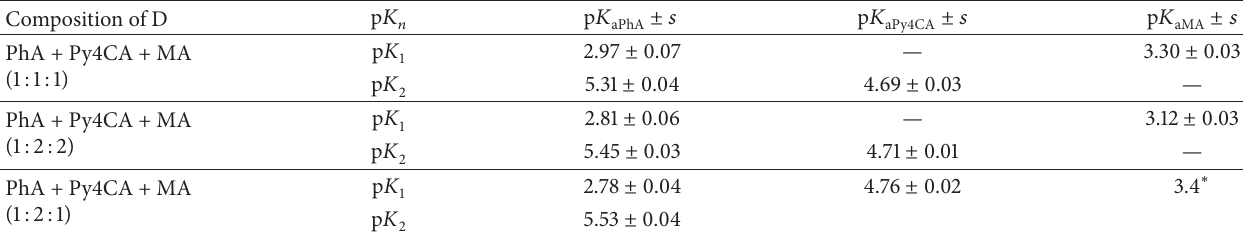
Table 3: The experimental p 𝐾 data obtained for the mixture of PhA, Py4CA, and MA at various compositions of titrand D. a Composition of D